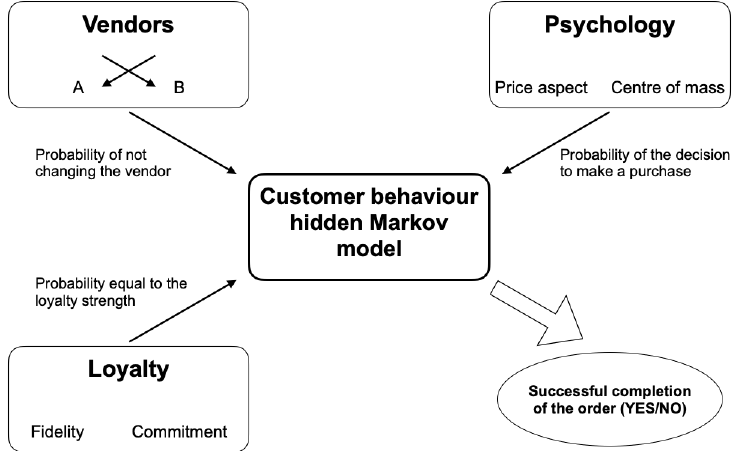
Figure 1. The structure of the Customer behaviour hidden Markov